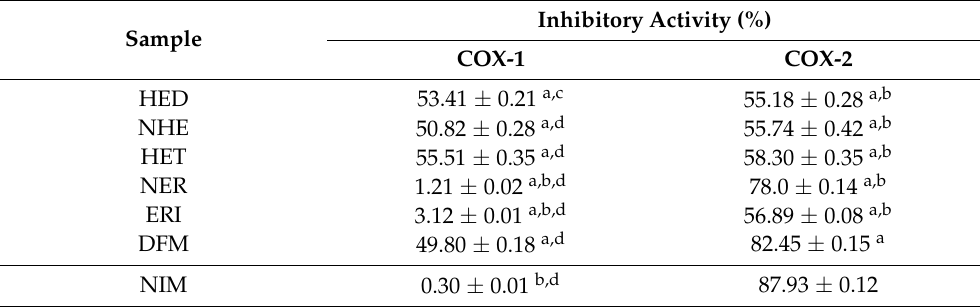
Table 2. Inhibitory activity of the flavanones hesperidin (HED), neohesperidin (NHE), hesperetin (HET), neoeriocitrin (NER), eriocitrin (ERI), digested flavanone mix (DFM), and nimesulide (NIM) as a reference standard, on human COX-1 and COX-2 enzyme